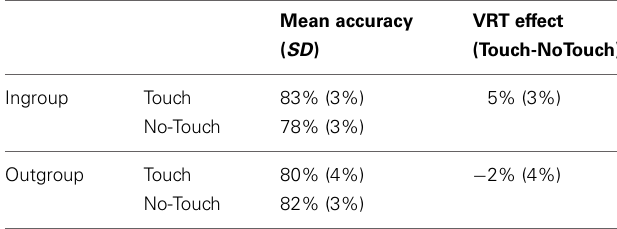
Table 1 | Mean scores ( ± standard error of the means indicated in brackets in italic font) for each Face (Ingroup and Outgroup) and for each Fingers’ Trajectory (Touch and No-Touch) conditions.